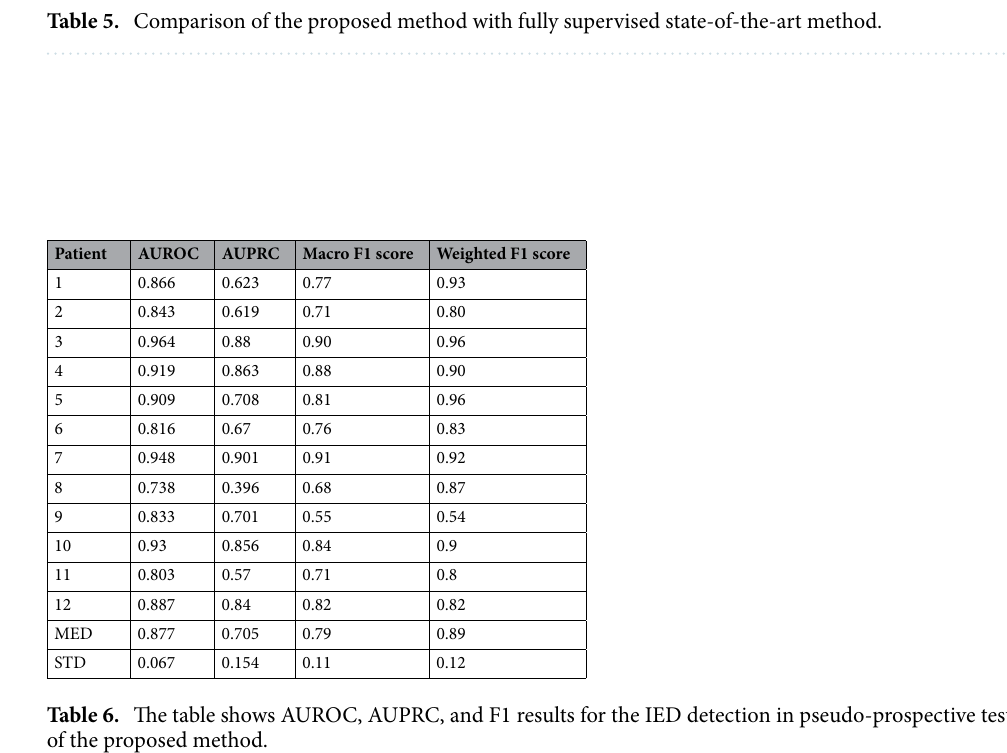
Method Fully supervised Nejedly et al. 36 (tens of thousands training samples)